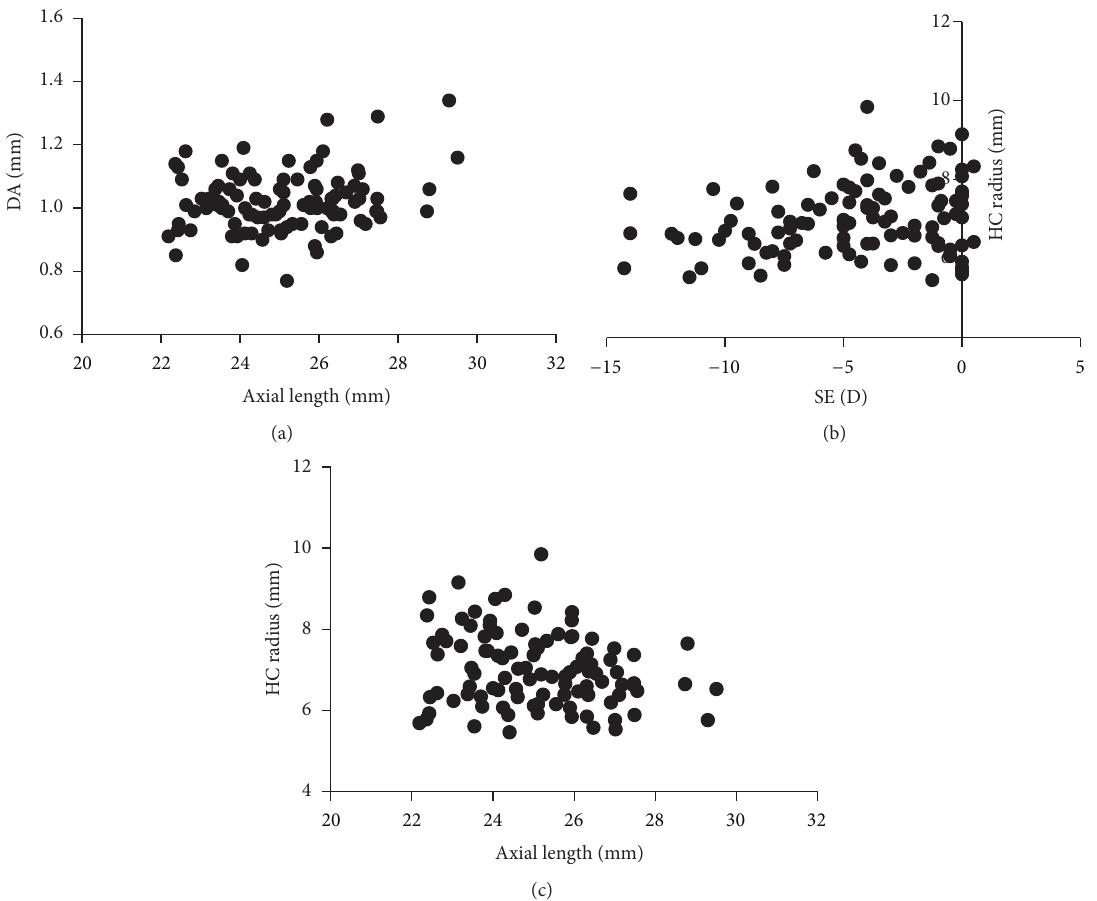
Figure 3: Scatter diagrams of bivariate correlation analysis. (a) Positive correlation between the deformation amplitude (DA) and axial length; (b) positive correlation between the HC radius and spherical equivalent (SE); (c) negative correlation between the HC radius and axial